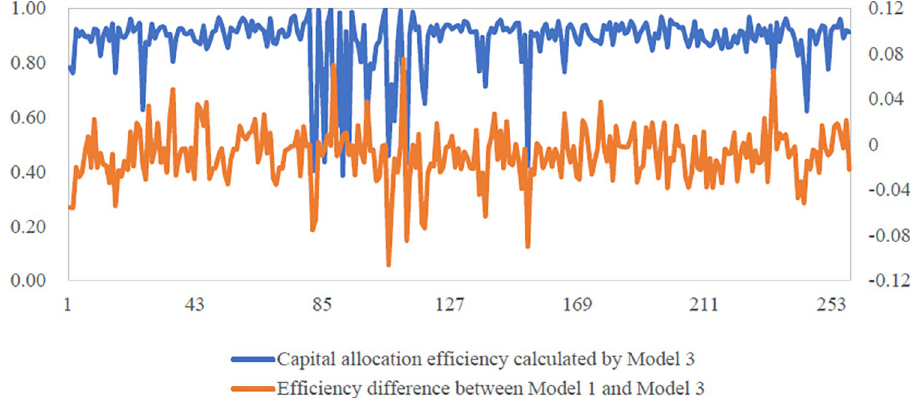
Fig 2. Distribution of differences in capital allocation efficiency between Model 1 and Model